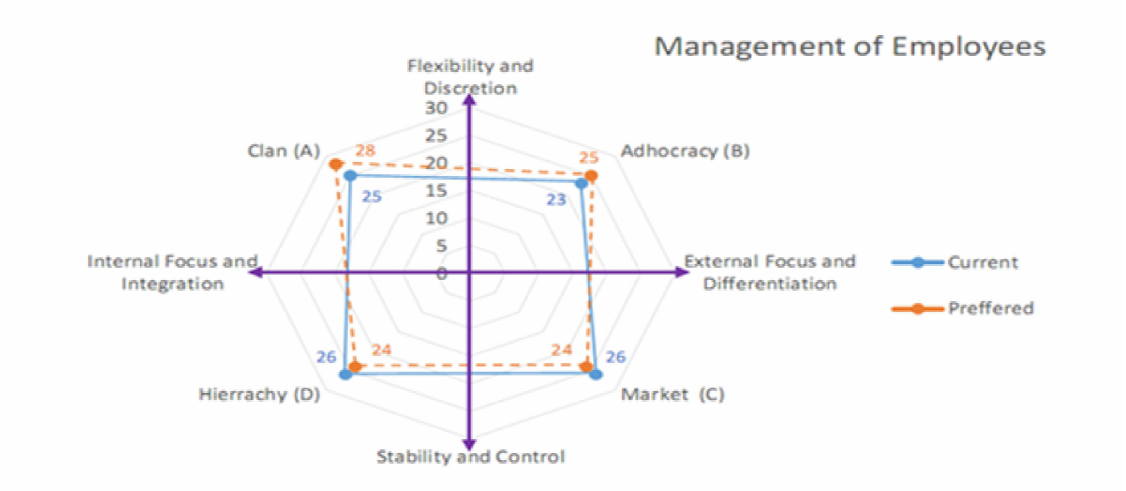
Figure 6. Radar diagram of dimension of management of